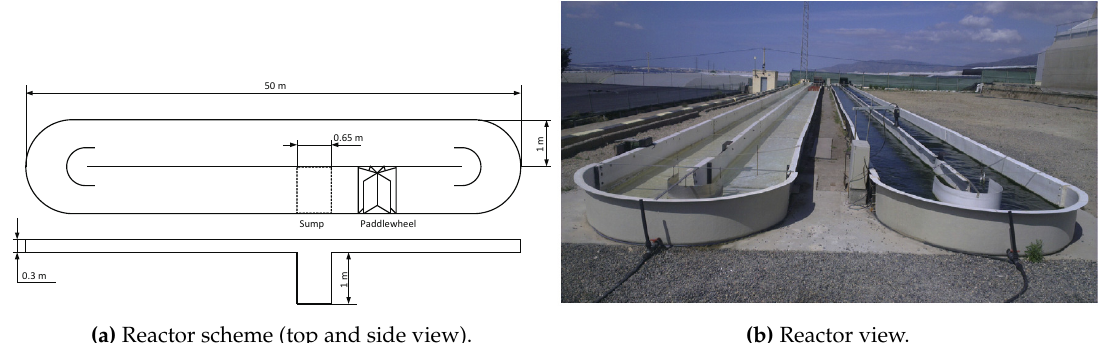
Figure 1. Raceway reactor used in this work for simulation.